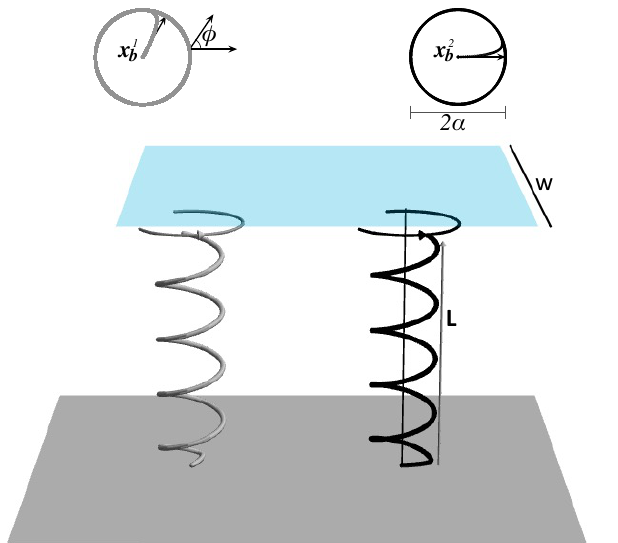
Figure 1. A sketch of a carpet consisting of two helices and a square flow meter (7) above it. The top view of the helices is also shown. The bases of the helices are attached to an infinite, planar, and solid wall located at z =